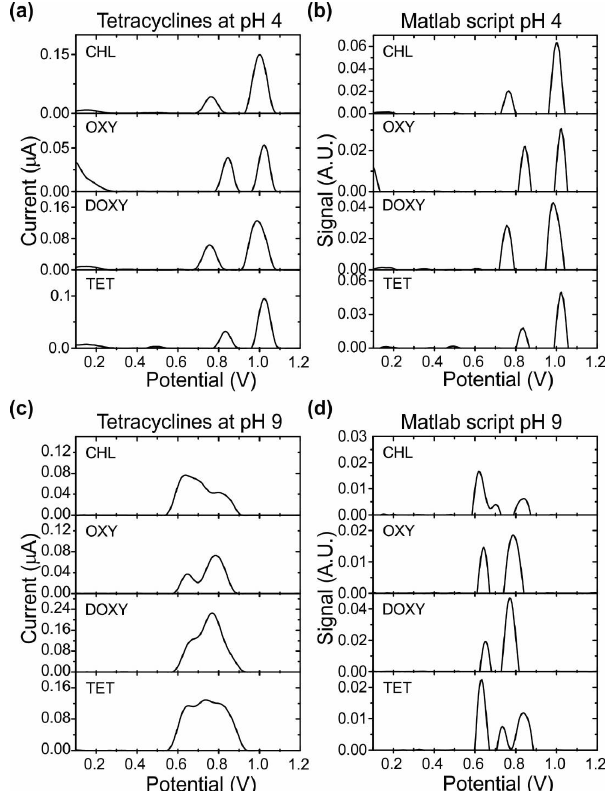
Figure 5. Data treatment with Matlab script to improve peak separation/identification. ( a ) Baseline- corrected SWVs of tetracyclines at pH 4, ( b ) output signal after the application of the script at pH 4, ( c ) baseline-corrected SWVs of TCs at pH 9, where overlapping of peaks exists, and ( d ) output signal after the application of the script at pH 9.